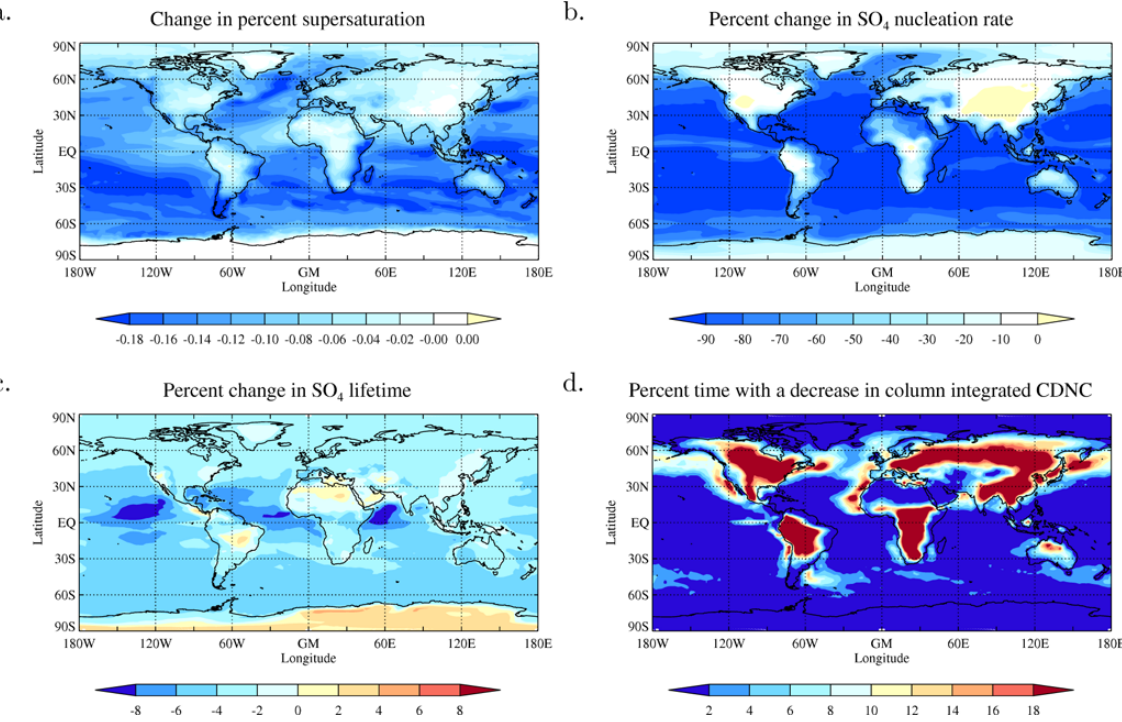
Fig. 6. NorESM: (a) change in percent cloud supersaturation with respect to water at ∼ 930hPa, (b) percent change in SO 4 nucleation rate at ∼ 930hPa, (c) percent change in SO 4 lifetime, and (d) percent time with a decrease in column integrated CDNC. All annual means.